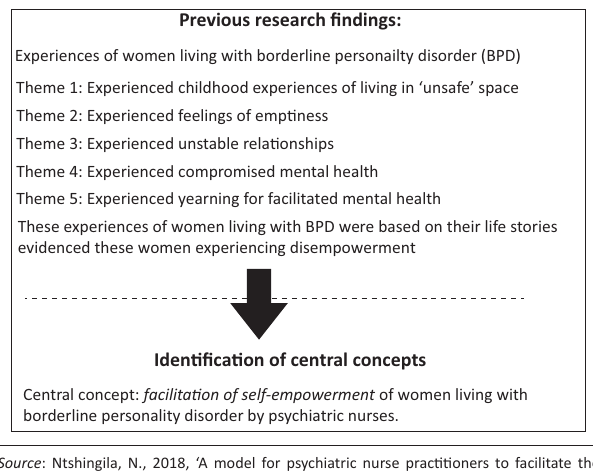
FIGURE 1: Identification of the central